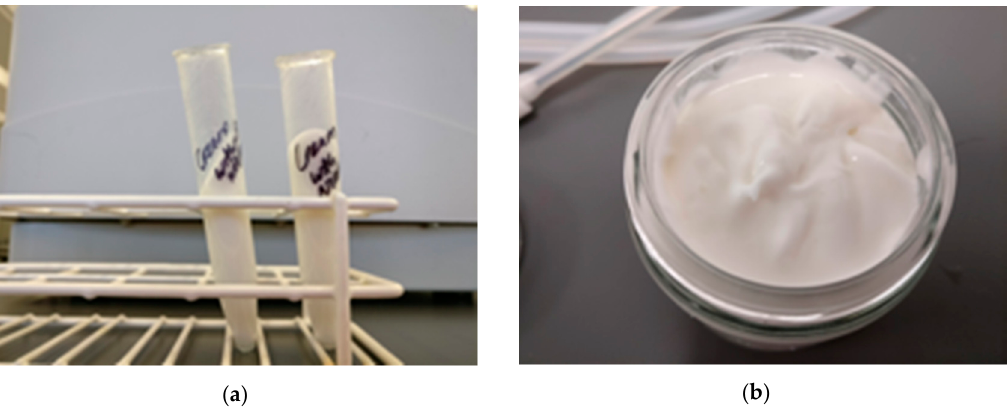
Figure 1. ( a ) Image of newly prepared oil-in-water cream formulation. ( b ) An active model and its Figure 1. (a) Image of newly prepared oil-in-water cream formulation. (b) An active model and its baseline after centrifuging for 15 min at 3000 baseline after centrifuging for 15 min at 3000 rpm.